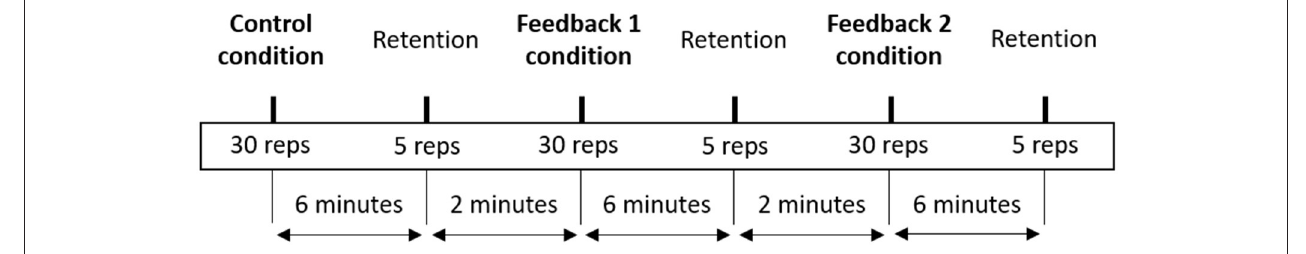
FIGURE 1 | Schematic overview of the experimental procedure.